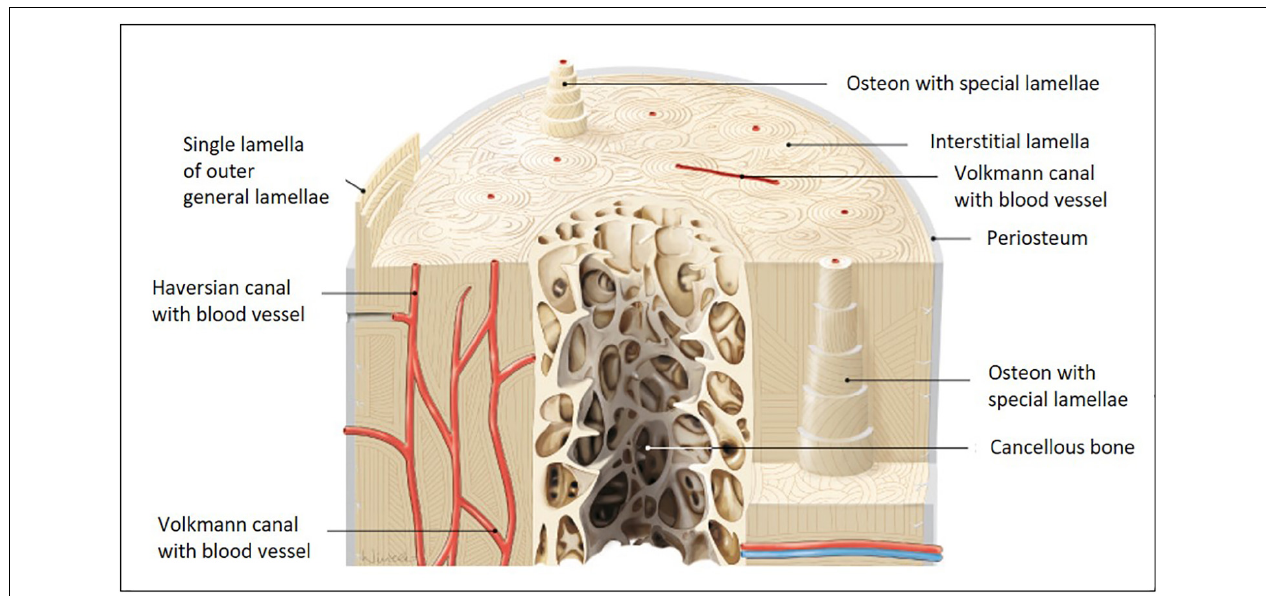
FIGURE 1 | Models of long bone anatomy. Human long bone anatomy at the diaphysis level shown on a cross and transverse section model. The cortical bone sheet is made up of osteons with Haversian and Volkmann canals. Osteons with special lamellae surrounding the Haversian canals are visible in detail in the model. The lamellae are formed from sheets of aligned collagen-I fibers and fiber bundles, which are gradually shifted in an oriented manner. Their substructure is very characteristic and is built from fibers with alternating orientations (image adapted from Paulsen and Waschke,